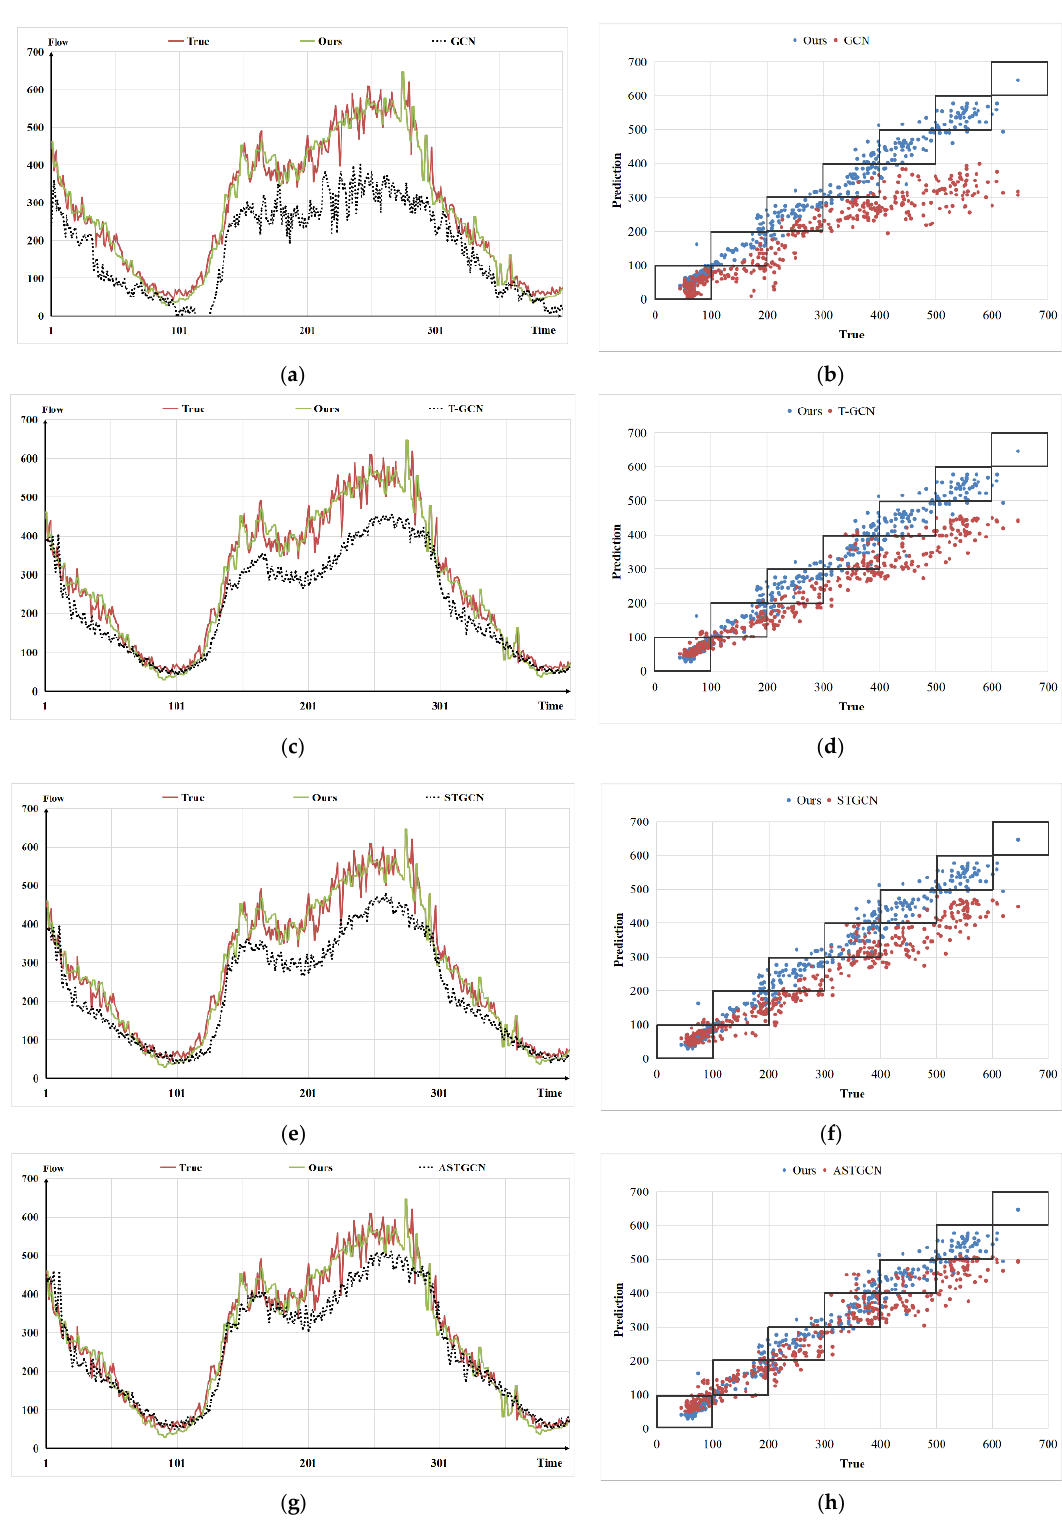
Figure 13. Comparison of the GSTNCNI experimental results with four models containing graph convolutional neural networks on the same data. ( a ) Comparison between GSTNCNI and GCN; ( b ) Scatter diagram of GSTNCNI and GCN prediction results; ( c ) Comparison between GSTNCNI and T-GCN; ( d ) Scatter diagram of GSTNCNI and T-GCN prediction results; ( e ) Comparison between GSTNCNI and STGCN; ( f ) Scatter diagram of GSTNCNI and STGCN prediction results; ( g ) Comparison between GSTNCNI and ASTGCN; ( h ) Scatter diagram of GSTNCNI and ASTGCN prediction results.